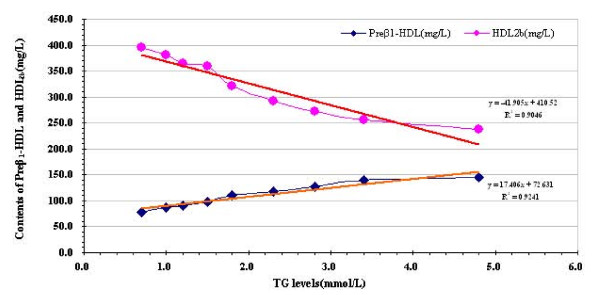
The contents of preβ1-HDL and HDL2b according to approximately equal ninths of baseline TG for the entire study population.